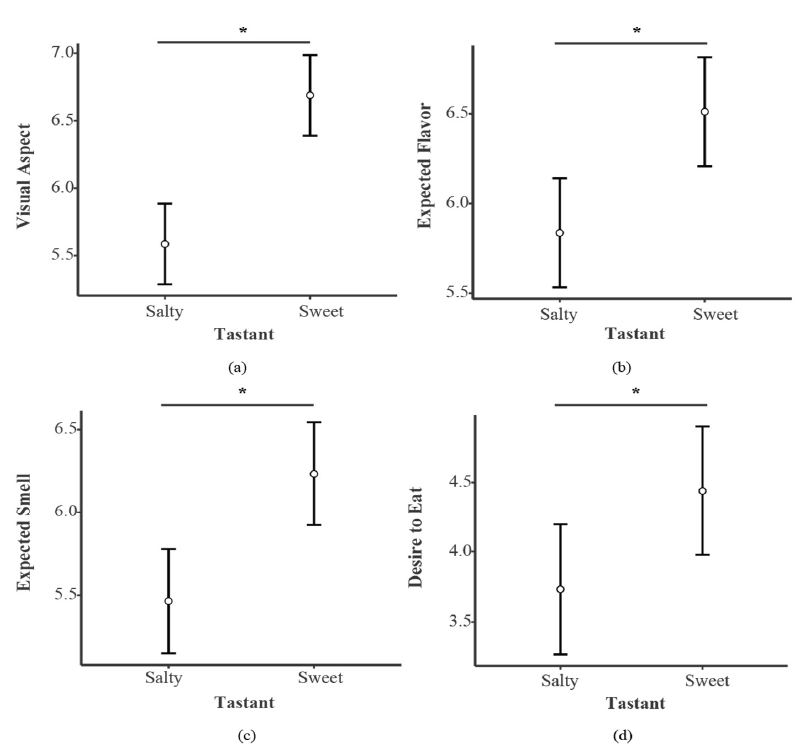
Figure 2. Main results for Tastant in each evaluated dimension, i.e., ( a ) Visual Aspect, ( b ) Expected Flavor, ( c ) Expected Smell and ( d ) Desire to Eat. Bars indicate confidence intervals (95%). * p < 0.05. Further, we found interaction effects for Priming*Calories (F 1,84 = 10.826, p < 0.001, η 2p = 0.114) and Priming*Calories*Tastant (F 1,84 = 7.019, p < 0.010, η 2p = 0.077). Bonferroni post